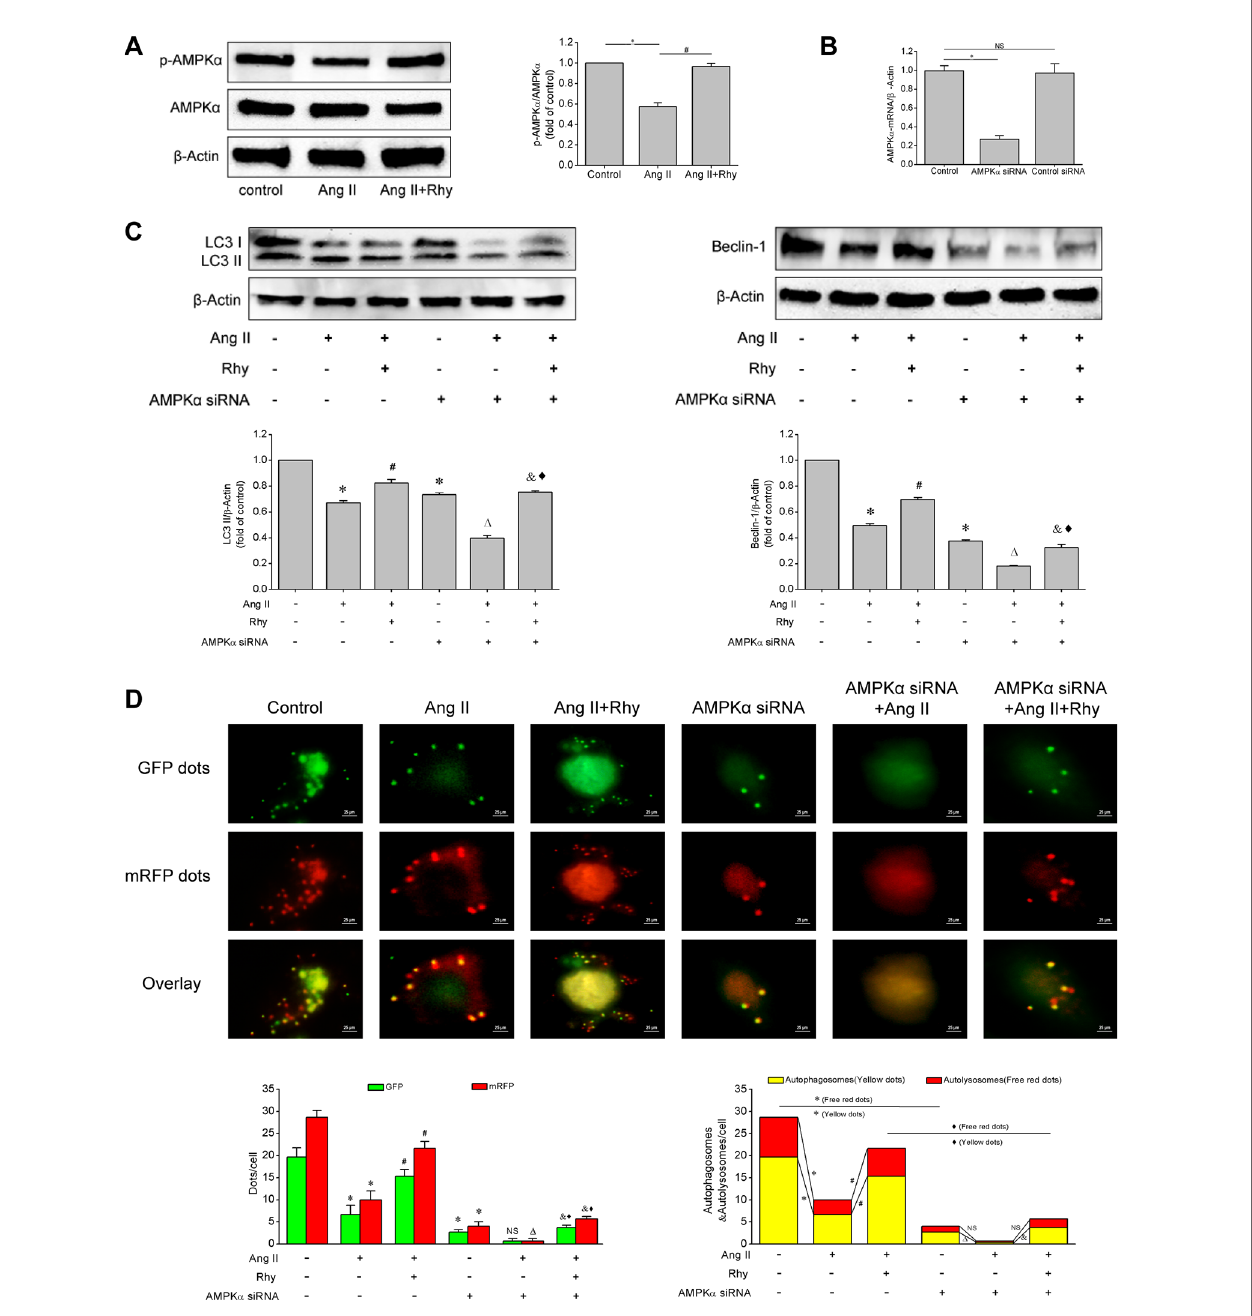
FIGURE 6 | Rhynchophylline enhanced autophagy by activating AMPK signaling pathway. (A) Western blot analysis of p-AMPK a and AMPK a expression in EPCs in indicated groups. The data was presented in fold of control. (B) The mRNA expression of AMPK a detected by qRT-PCR in indicated groups. (C) Western blot analysis of LC3-II and beclin-1 expression in EPCs in indicated groups. The data was presented in fold of control. (D) Representative images and quantitative analysis of mRFP-GFP-LC3 immuno fl uorescence (400× magni fi cation). All data were pooled as mean ± S.D. (error bars) from three independent biological repeats experiments, each of which included 3 technical repeats. *P < 0.05 vs control group; # P < 0.05 vs Ang II group; D P < 0.05 vs AMPK a siRNA group; & P < 0.05 vs AMPK a siRNA+Ang II group; ⋄ P < 0.05 vs Ang II+Rhy